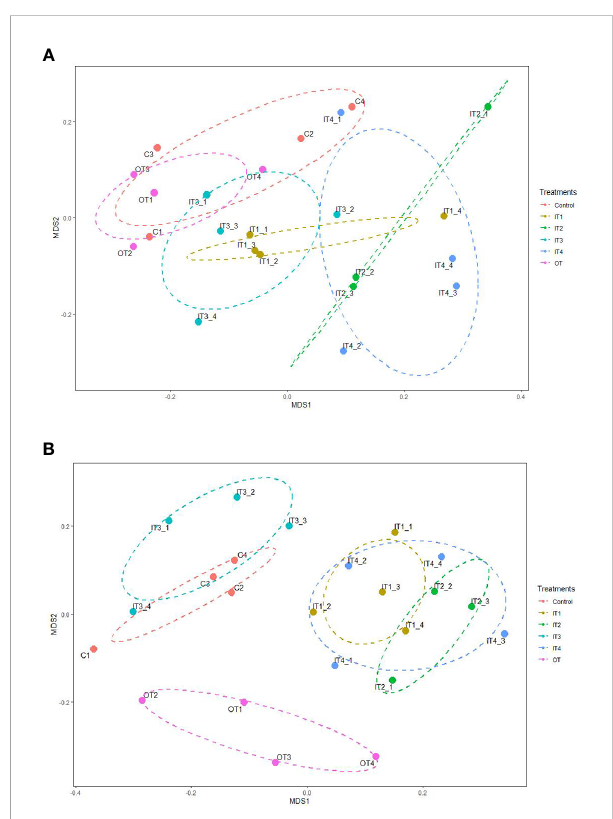
FIGURE 2 (A) Non-metric multidimensional scaling (NMDS) analysis on a Bray- Curtis dissimilarity matrix based on the ASVs dataset retrieved from the bacterial communities of the rhizospheric soil of purslane under different fertilization treatments. Ellipsoids represent 95% con fi dence for each treatment mean. (B) Non-metric multidimensional scaling (NMDS) analysis on a Bray-Curtis dissimilarity matrix based on the ASVs dataset retrieved from the fungal communities of the rhizospheric soil of purslane under different fertilization treatments. Ellipsoids represent 95% con fi dence for each treatment